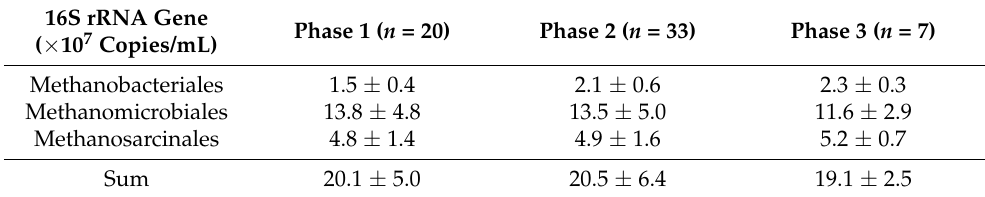
Table 2. The methanogen population structures at different phases.